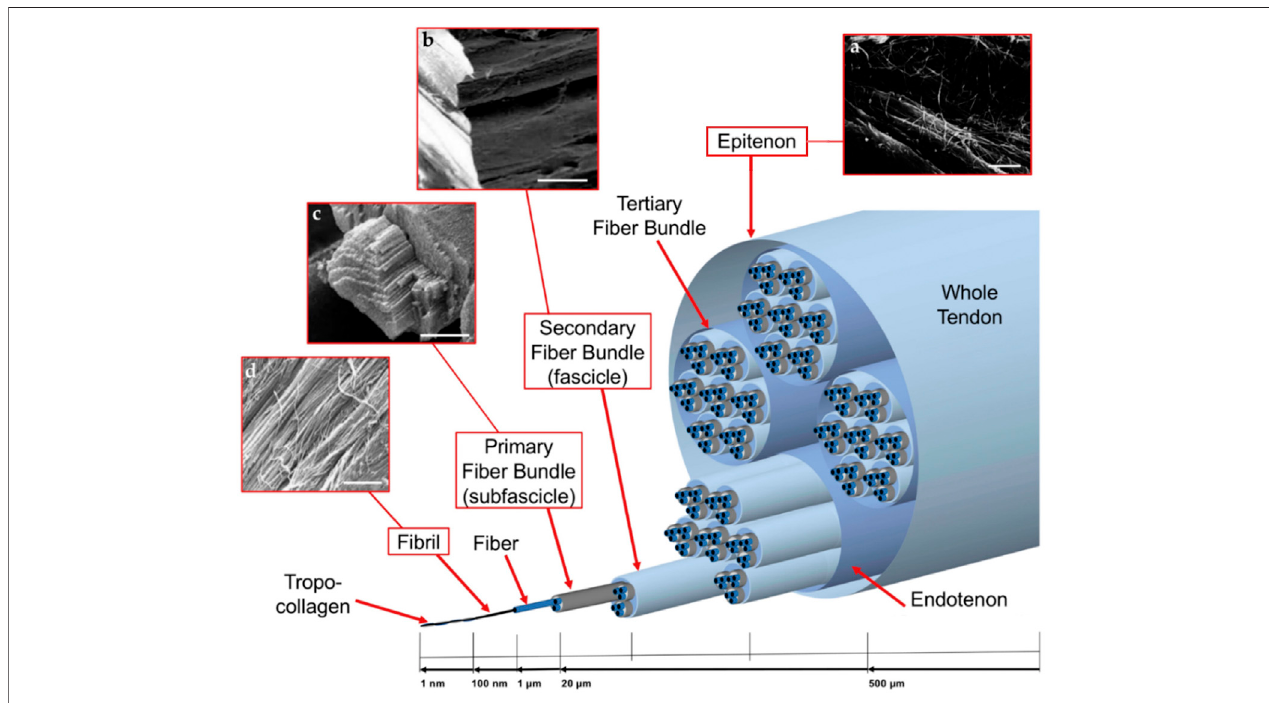
FIGURE1| Gradedarrangementofthecollagenoftendons: (A) SEMimageofepitenon fi brils(scale=2 microns); (B) SEMimageofsecondary fi berbundle(scale= 100 micron); (C) SEM images of primary fi ber bundle (scale = 45 microns); and (D) SEM image of collagen fi brils (scale = 1.8 micron). Permission to reproduce was granted under the conditions of the license (CC BY 4.0). Copyright 2018, Sensini et al.